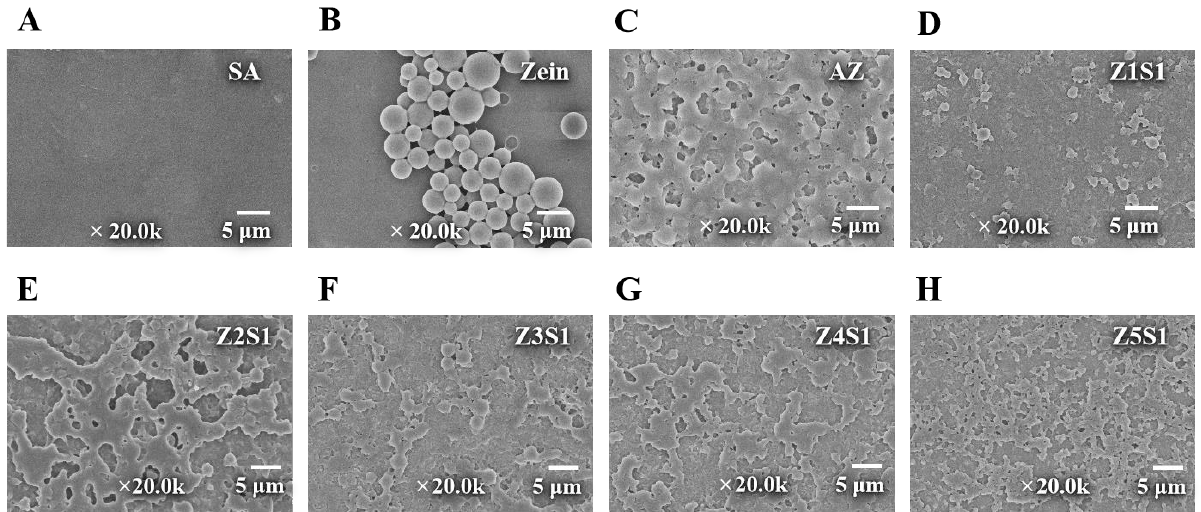
Figure 5. FESEM of SA, zein, AZ, and ZS particles with different ratios.